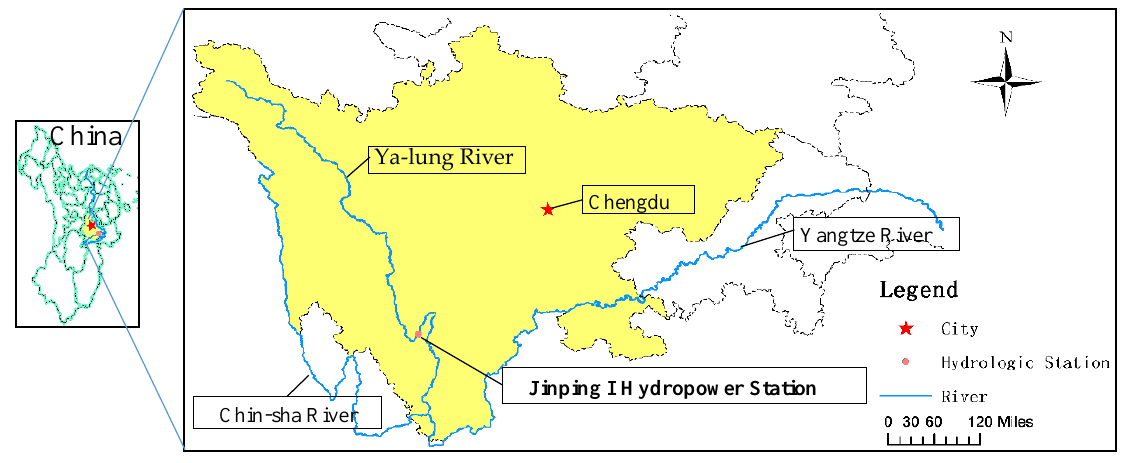
Figure 1. Location of the study area.